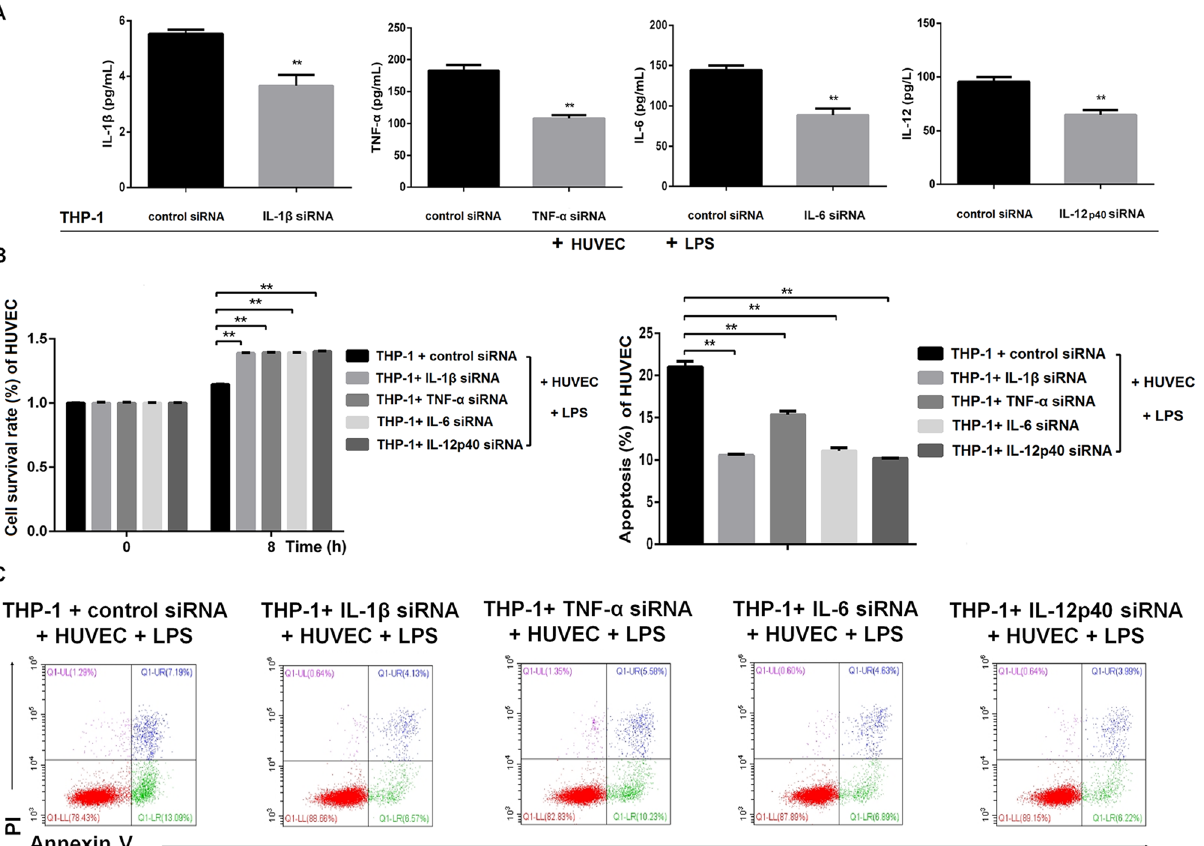
Figure 2. Knockdown of proinflammatory cytokines in THP-1 cells attenuated LPS-induced dysfunction of HUVECs. THP-1-derived macrophages were transfected with siRNA oligos targeting IL 1β, TNF α, IL 6 and IL 12 p40 or control siRNA for 24 h, and then co-cultured with HUVECs upon LPS (100 μg/mL) stimulation for 8 h. ( A ) siRNA-mediated knockdown of IL-1β, TNF-a, IL-6 and IL-12p40 in THP-1-derived macrophages resulted in significant reduction of soluble cytokine levels in the supernatant of the co-culturing, as measured by ELISA. ( B ) siRNA-mediated knockdown of the proinflammatory cytokines in THP-1-derived macrophages significantly attenuated the impairment of cell proliferation in HUVECS after the co-culture. Cell viability was detected by CCK8 at 0 h and 8 h. ( C ) siRNA-mediated knockdown of the proinflammatory cytokines significantly attenuated the apoptosis of HUVECs after the co-culture. Apoptosis of HUVECs was quantitated by Annexin V and PI staining via flow cytometry. Annexin V + cells are considered as apoptotic cells. n = 3 for each group. Data are expressed as mean ± Ang1 negatively regulated the phosphorylation of p65 in HUVECS.